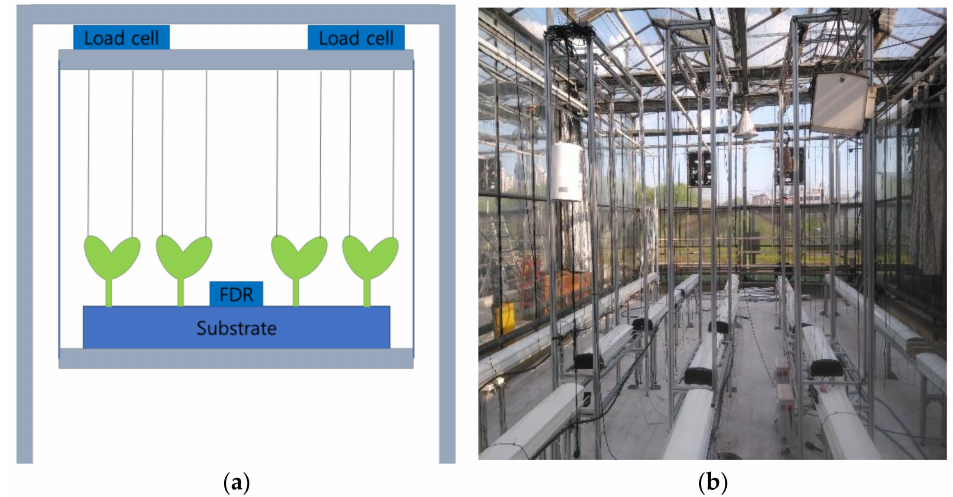
Figure 1. A schematic diagram of the fresh weight measuring system using the load cell and frequency domain reflectometry (FDR) sensors ( a ), and the actual installation of the fresh weight measuring system ( b ).